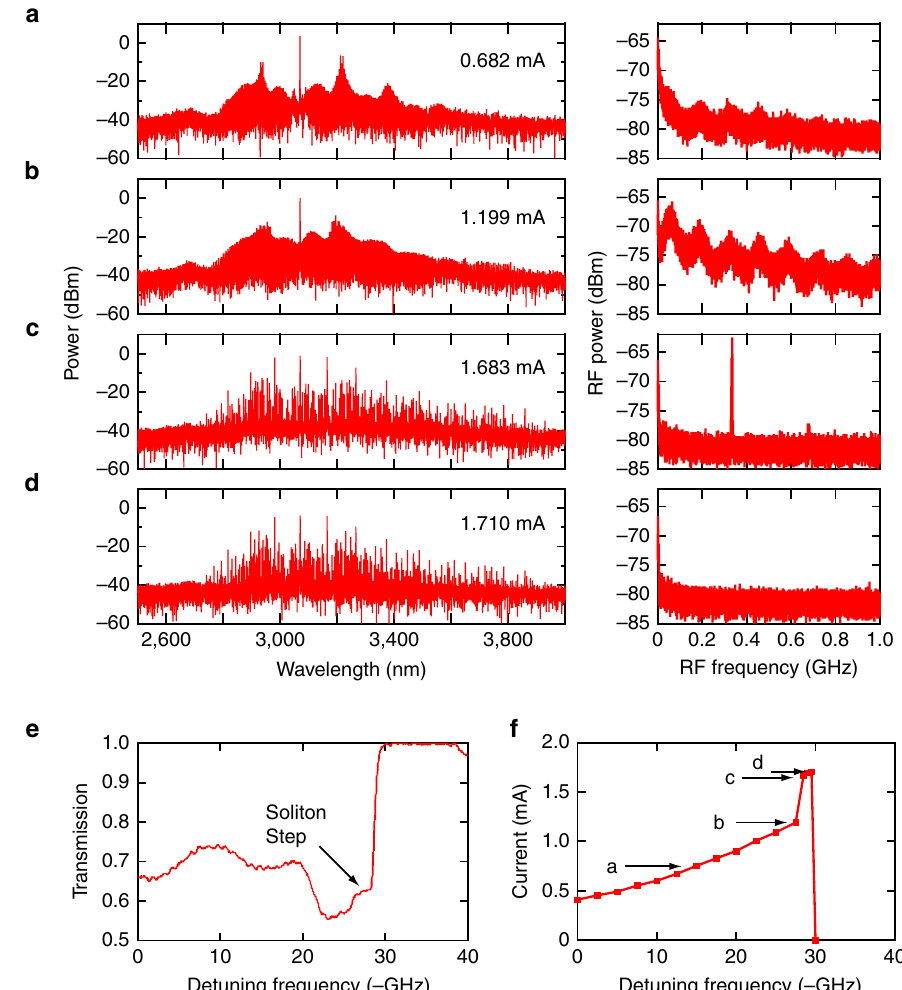
Figure 3 | Observation of breather solitons in Si microresonators. ( a – d ) Optical and RF spectral evolution where the state ( c ) shows breather solitons in Si. Optical spectrum in d spans 0.8 of an octave (from 2.4 to 4.3 m m). No other significant features are observed in the RF spectra beyond 1GHz up to 12GHz. ( e ) The pump power transmission in Si as the laser frequency is scanned across the resonance. ( f ) Three-photon-absorption-induced current measured by scanning the pump detuning. Arrows correspond to four states (a–d), which are (a,b) unstable modulation instability states, (c) breather soliton and (d) stable soliton